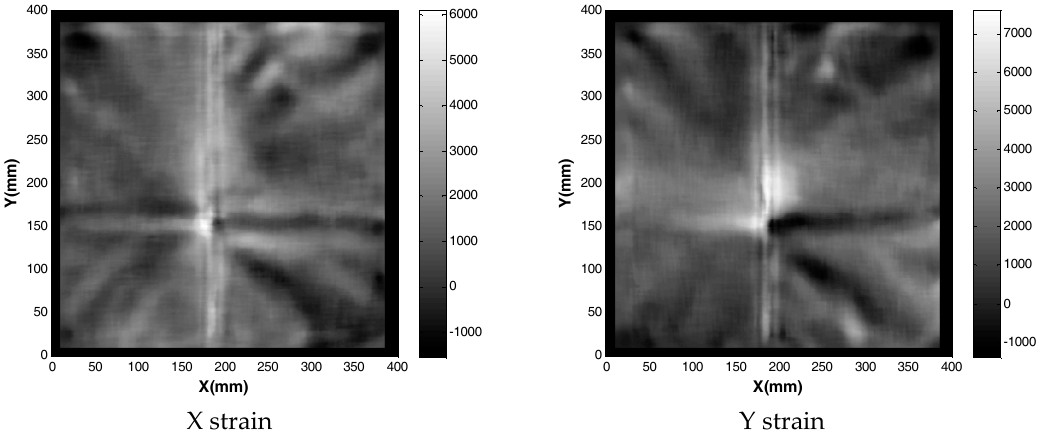
Figure 17. The von Mises stress distribution with one spacer placed beneath the membrane.